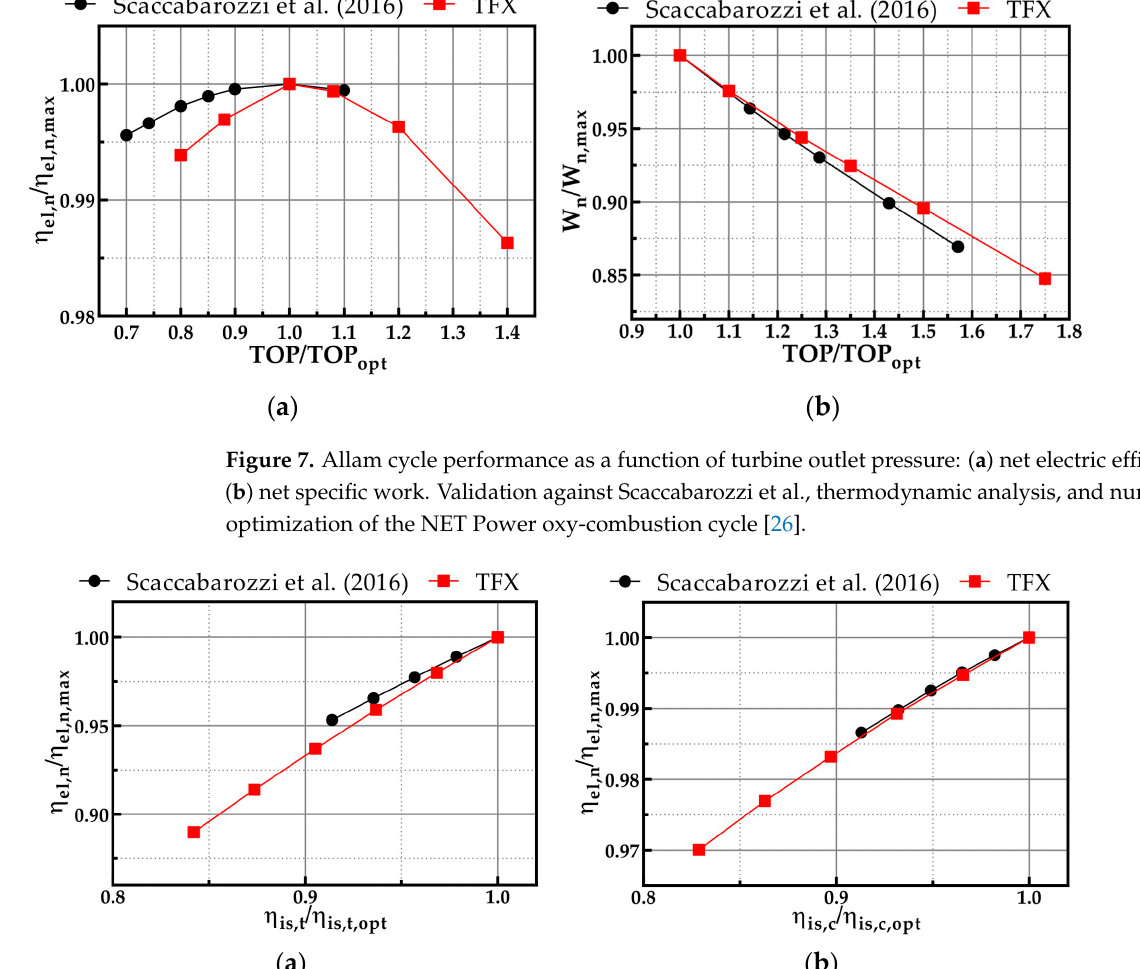
Figure 9. Net electric efficiency of the Allam cycle as a function of ASU-specific work. Validation against Scaccabarozzi et al., thermodynamic analysis, and numerical optimization of the NET Power oxy-combustion cycle [26]. 3.2.1. Turbine Inlet Temperature